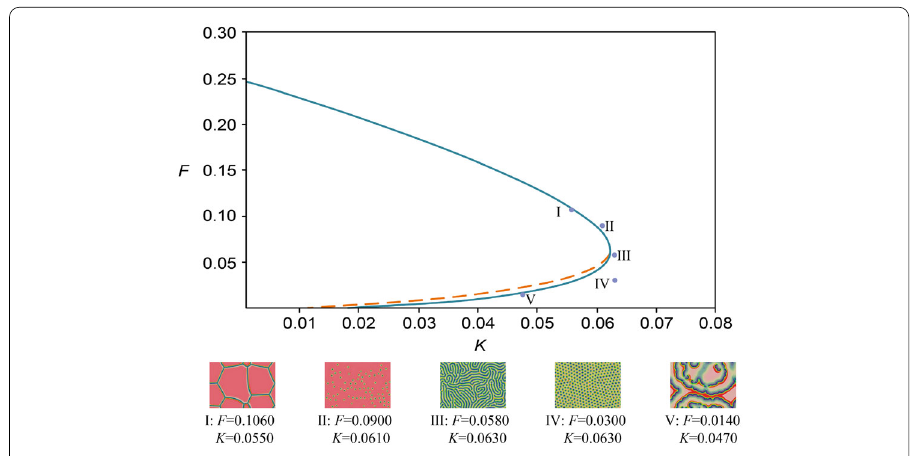
Fig. 1 The dotted line represent the bifurcation line. Several choices of the couple ( F,K ) reproduce different